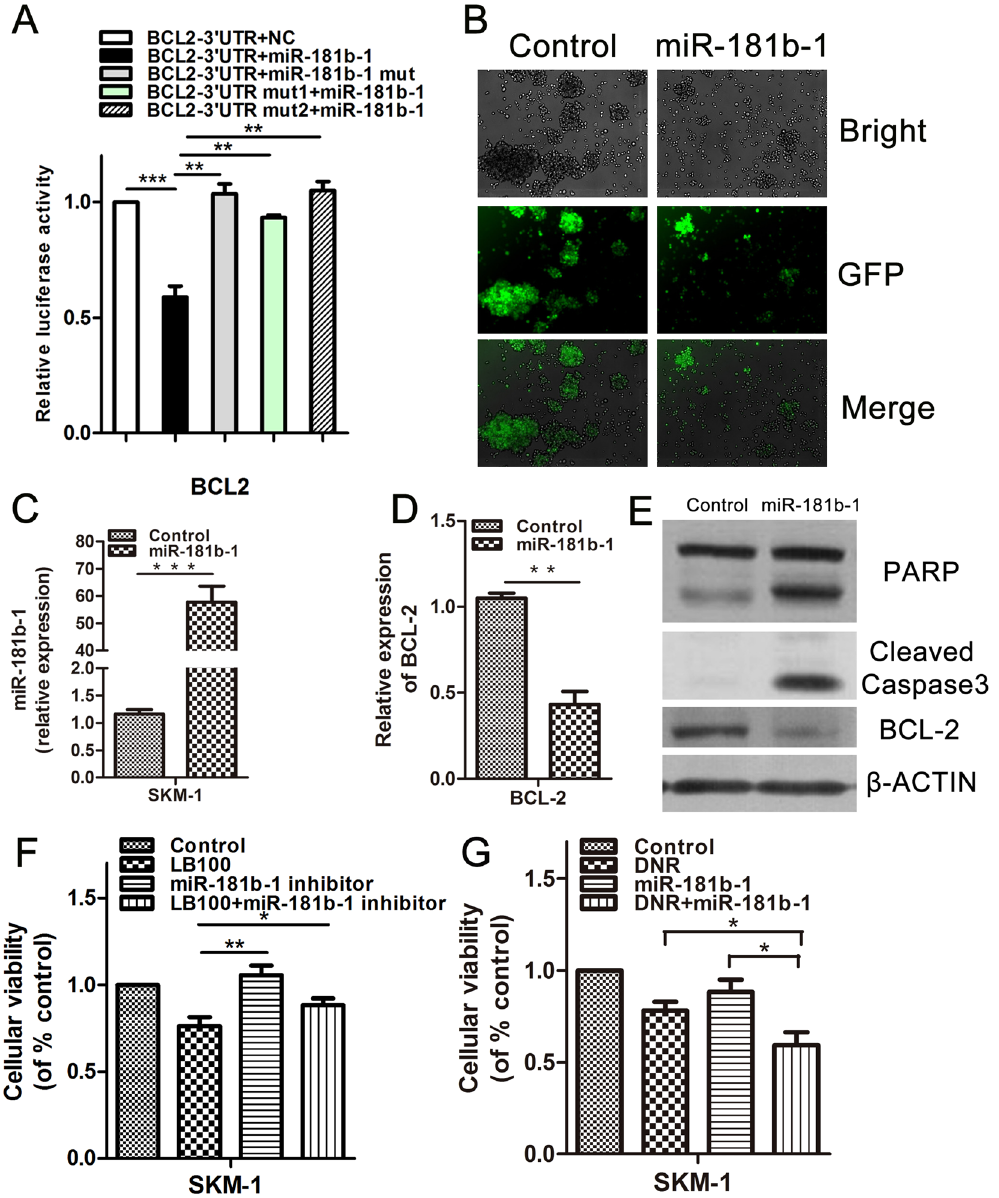
Figure 6. miR-181b-1 directly targets Bcl-2 to mediate chemosensitization of sAML cells to DNR. ( A ) Dual luciferase assay demonstrates a significant decrease in relative luciferase activity in 293T cells when pMIR- REPORT-Bcl-2-3 ′ UTR was coinfected with miR-181b-1 retrovirus, but not with normal control (NC) or mut- miR-181b-1. Mutation of the miR181b-1 binding sites on the Bcl-2 3 ′ UTR additionally did not demonstrate changes in luciferase activity after administration of miR-181b-1 retrovirus. ( B ) GFP was checked after SKM-1 cells were stably infected with miR-181b-1 retrovirus. ( C – E ) Overexpression of miR-181b-1 reduced Bcl-2 mRNA and protein levels in SKM-1 cells, and induced expression of cleaved caspase 3. ( F ) Reversal of LB100 (2.5 μ M) induced SKM-1 cell death was noted after administration of anti-miRNA targeting miR-181b-1 (20 nM). ( G ) Overexpression of miR-181b-1 significantly enhanced the cytotoxic activity of DNR in sAML cells. Statistically significant differences are marked by an asterisk ( * P < 0.05; ** P < 0.01, *** P ≤